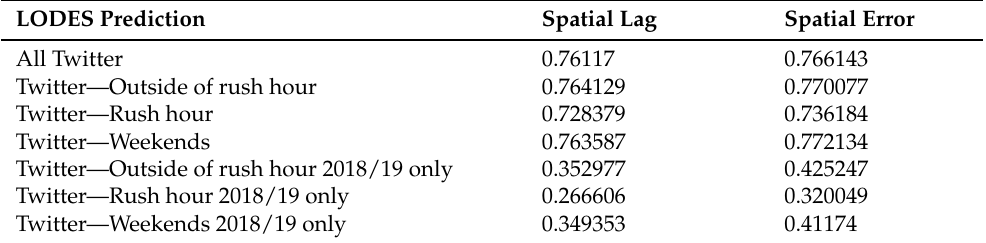
Table 3. Explanatory power of different Twitter data subsets predicting LODES street segment loads. LODES Prediction Spatial Lag Spatial Error All Twitter 0.76117